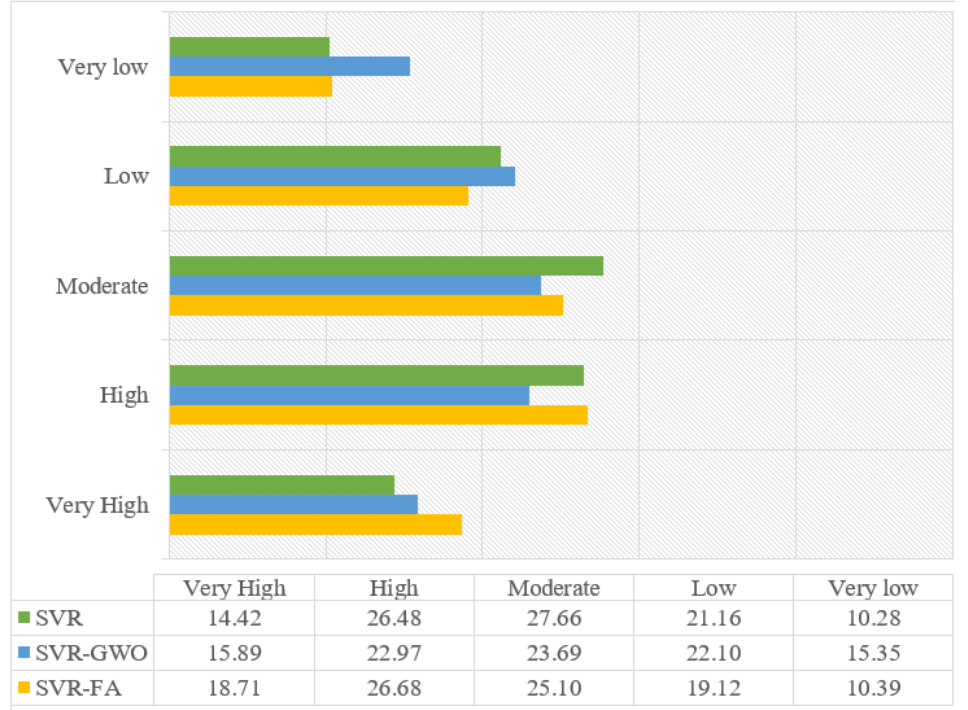
Figure 13. Percentages of landslide susceptibility classes.